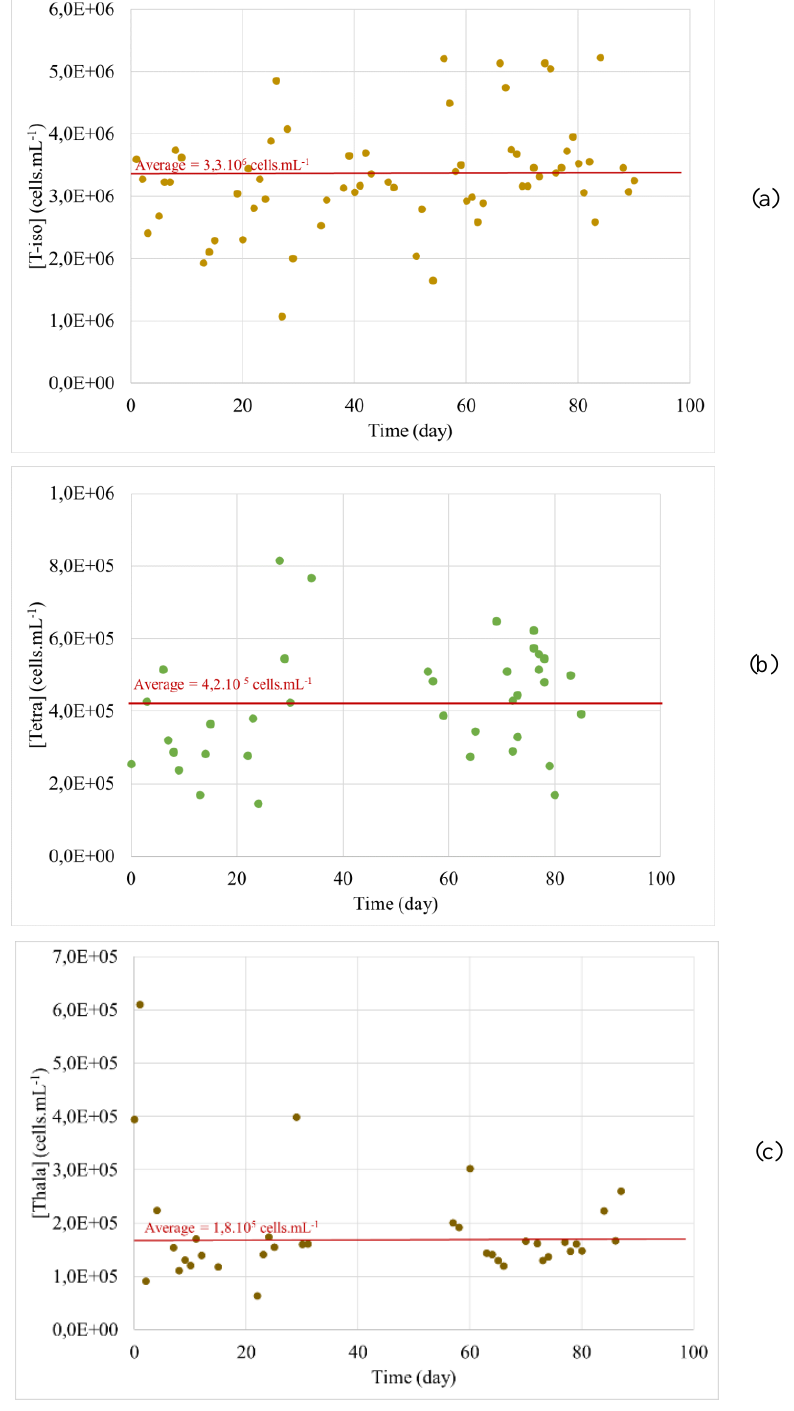
Figure 4. Monitoring of concentrations in Isochrysis, Tetraselmis and Thalassosiera weisfogii over 4